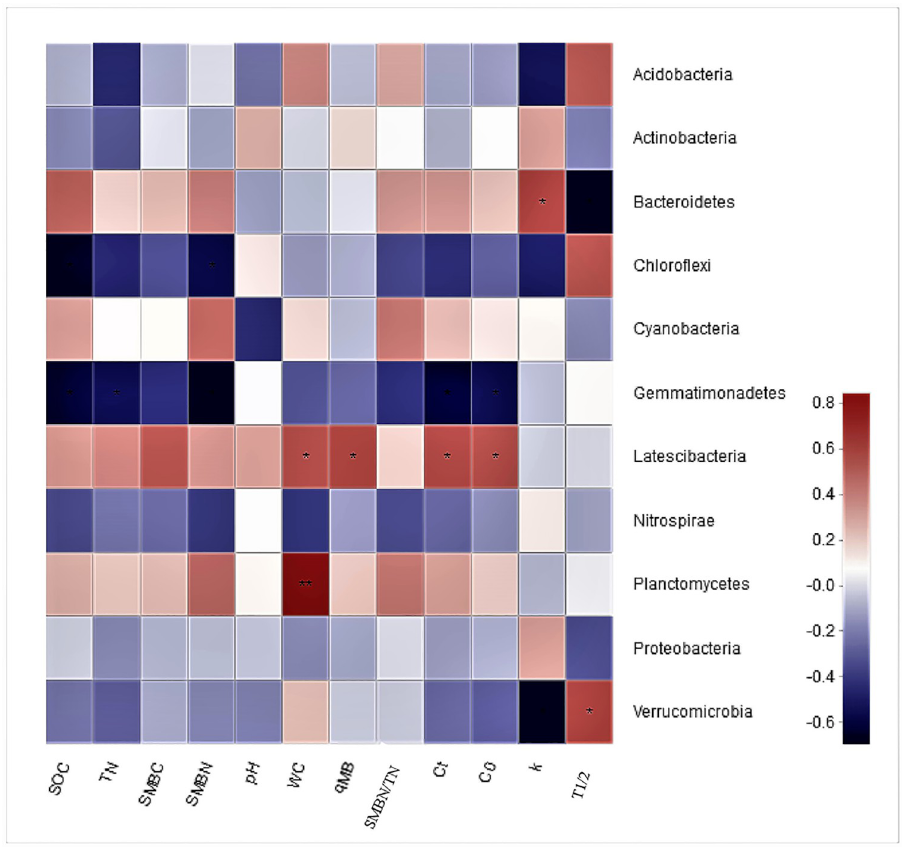
Fig 5. Pearson correlation heatmap of microbes and environmental variables and mineralization parameters. The X-axis and Y-axis represent the environmental factors and bacterial species, respectively. Color variations reflect positive (red) or negative (blue) correlation and the color depth indicates the level of positive or negative correlation, i.e. the darker the color, the better the correlation, as shown by the scale on the right. A P value less than 0.05 is denoted with � , a P value less than 0.01 is denoted with ��